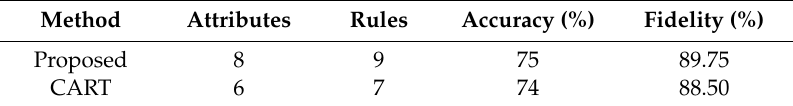
Table 4. Results of rule extraction for VTD